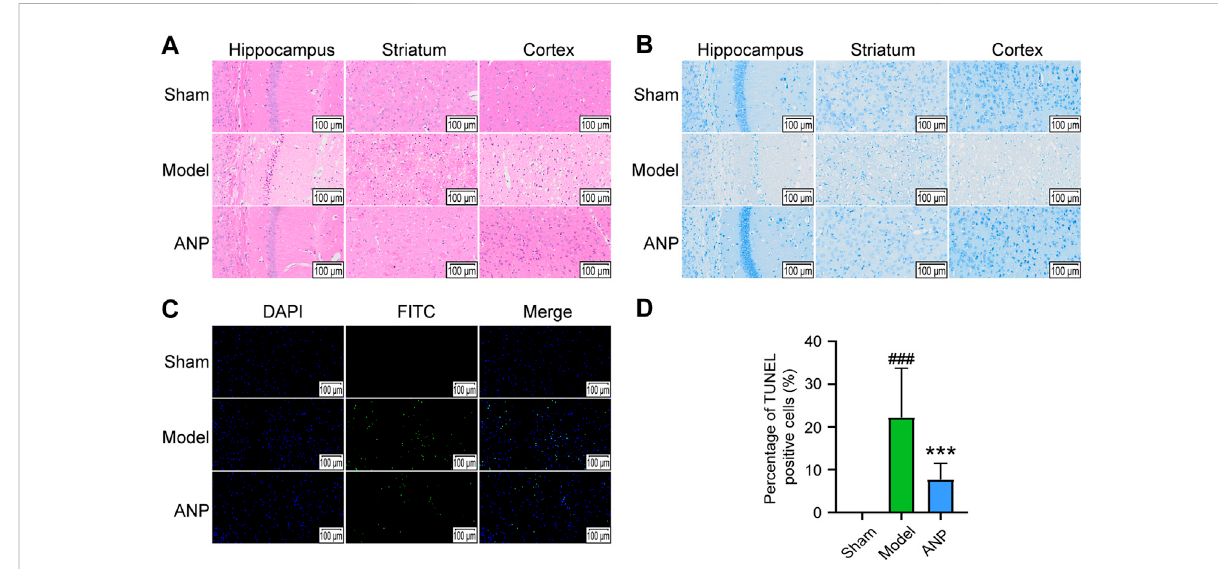
FIGURE 2 ANPalleviatedthepathologicalinjury. (A) TherepresentativeimagesofHEstaining( n =3). (B) TherepresentativeimagesofNisslstaining( n =3). (C) The representative images of TUNEL staining ( n = 3). (D) The percentage of TUNEL positive cells. Magni fi cation of 300 ×. Statistical differences were examined by one-way ANOVA. ### p < 0.001 compared with the sham group; *** p < 0.001 compared with the model group.